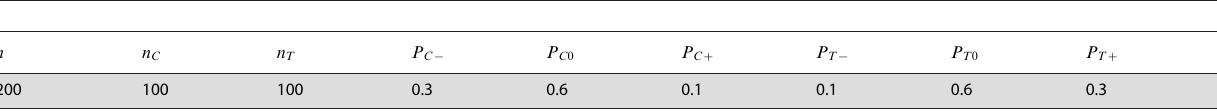
Table 2. A summary of the trial size, the split of participants into groups and their auxiliary subgroups, used to generate data for the initial experiment.